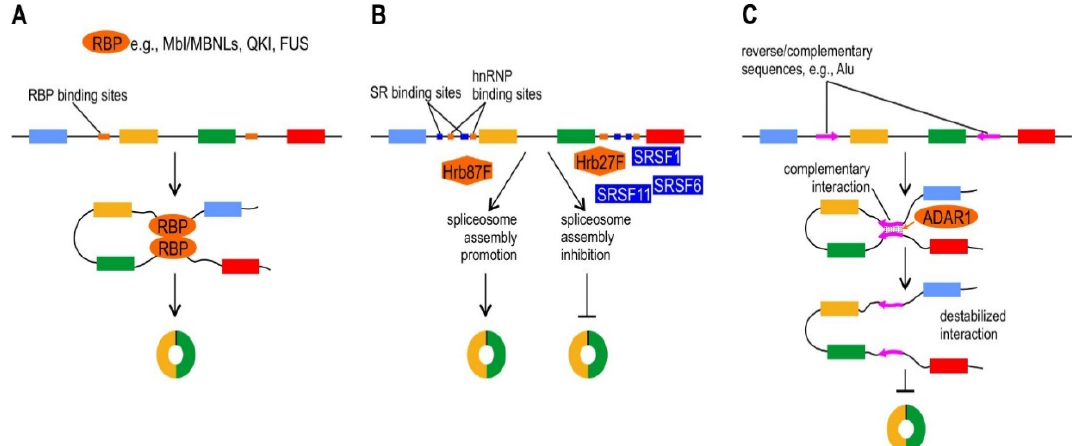
Figure 2. Proteins involved in circRNA biogenesis and potential mechanism of their actions. Exons are represented by rectangles, as in Figure 1, the “T” bars indicate inhibition of circRNA formation. ( A ) Mbl/MBNLs, Quaking (QKI) and Fused in Sarcoma (FUS) proteins can promote circRNAs biogenesis via binding in their RNA-binding motifs in introns adjacent to the back-splicing junctions facilitating the bridging process. ( B ) hnRNPs (heterogeneous nuclear ribonucleoproteins) and SR (serine-arginine) proteins can act in a combinatorial manner to either stimulate or inhibit circRNAs formation. Depletion of SR proteins (SRSF1, SRSF11 and SRSF6) each can cause an increase of circRNAs level. Similarly, hnRNP protein Hrb27C acts to impede circRNAs generation, whereas Hrb87F can enhance the process. In addition, simultaneous depletion of Hrb27C with SRSF1, SRSF11 and SRSF6 cause an additive effect and increase of circRNAs expression, suggesting that each of these factors plays a non-redundant role. ( C ) ADAR1 protein hampers circRNAs biogenesis via destabilizing double-stranded RNA interactions of introns flanking circRNA-forming exons through site-specific deamination of adenosine bases to inosines. ADAR1 interferes with RNA-RNA interactions between inverted repeats present in circRNA-flanking introns (shown as pink arrows) and prevents the formation of structures promoting circularization of exons.